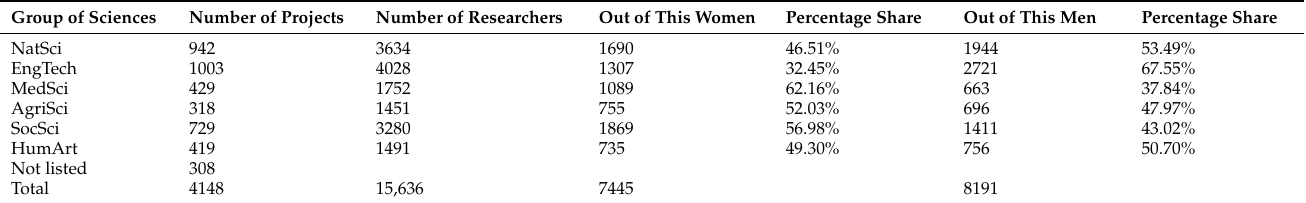
Table 4. Number of researchers in project teams by gender and groups of science and technology